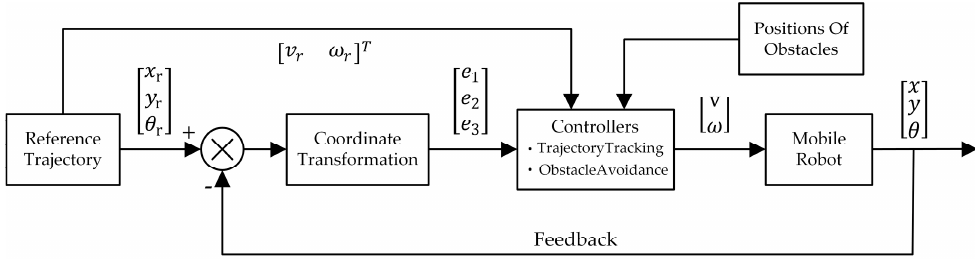
Figure 4. Structure of the proposed control scheme for the mobile robot.